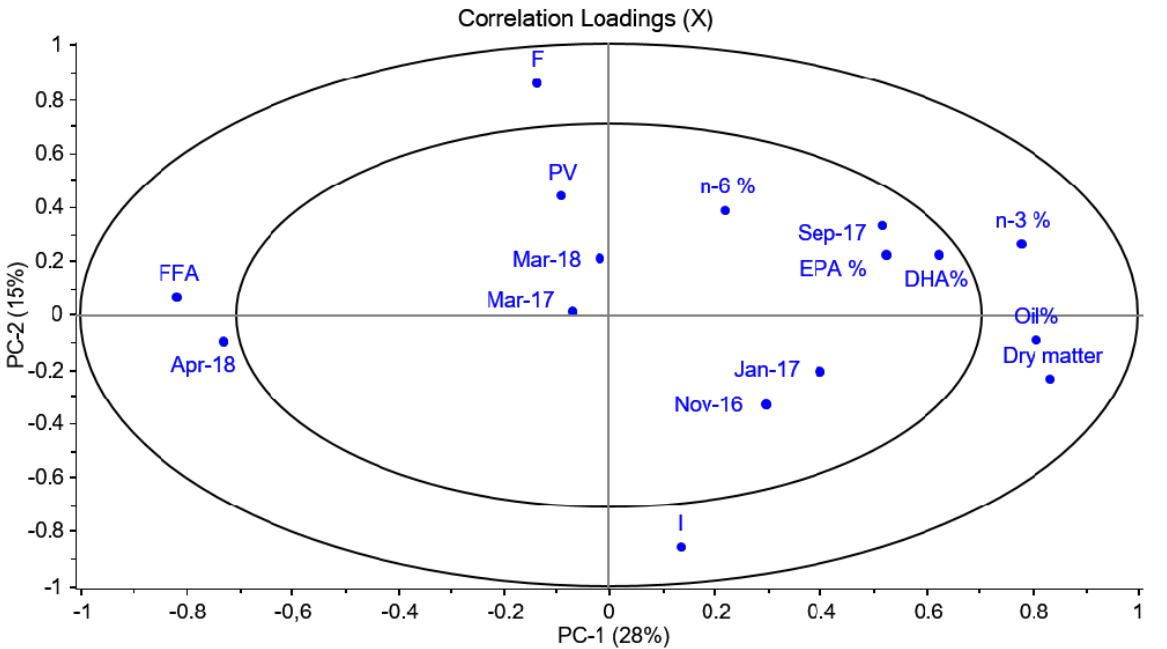
Figure A2. Loadings plot from PCA of ling samples and their oil content, dry matter, total n-3 PUFA %, total n-6 PUFA %, EPA %, DHA %, PV, FFA and information on storage conditions and sampling time. I Ice storage, F Frozen storage.